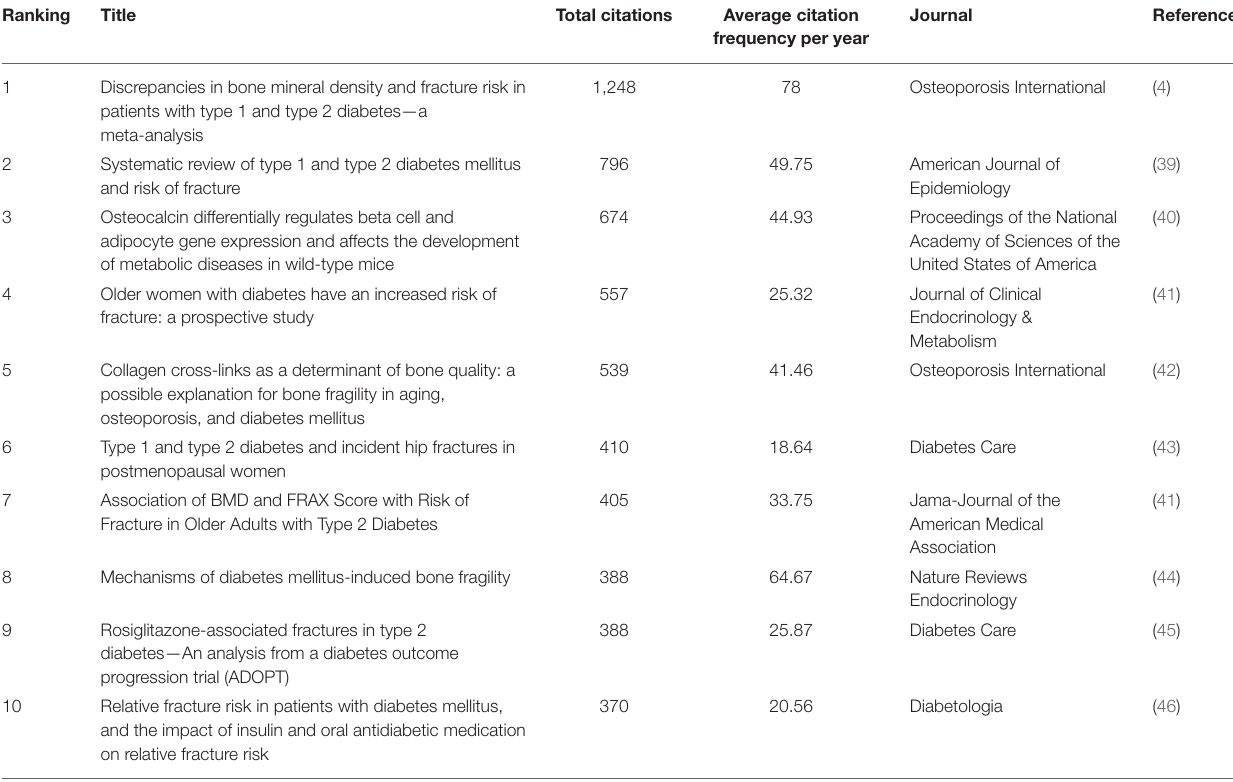
TABLE 3 | Characteristics of top 10 highly cited literatures on